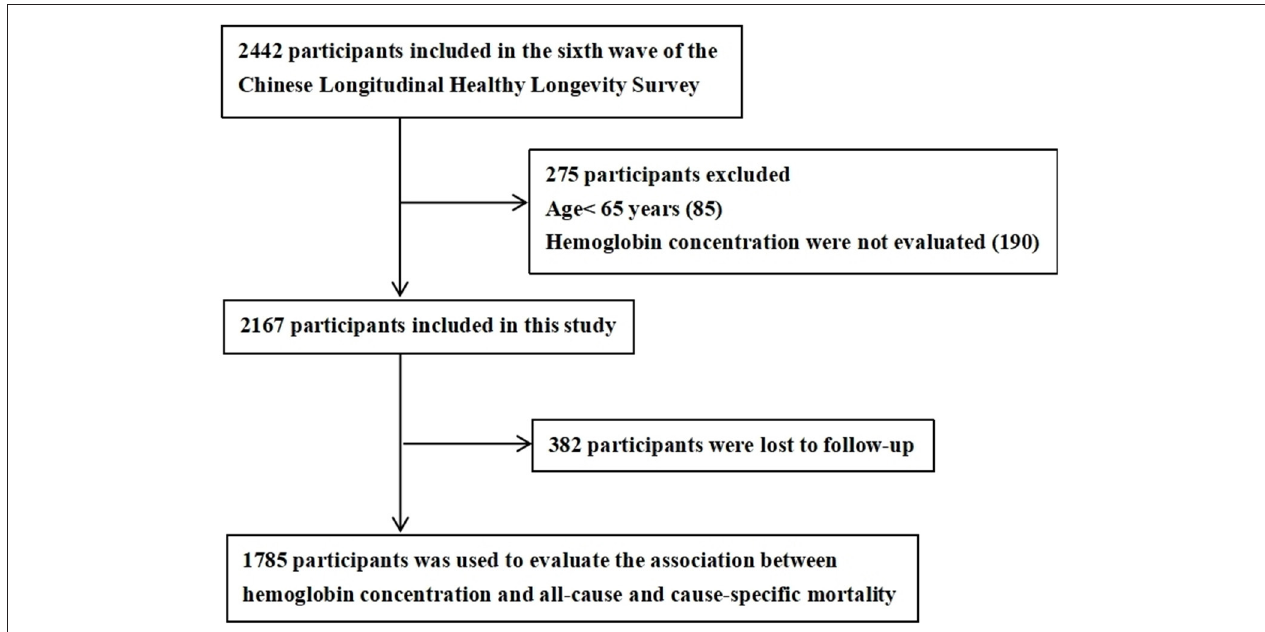
FIGURE 1 | A flowchart of the participant enrollment in the